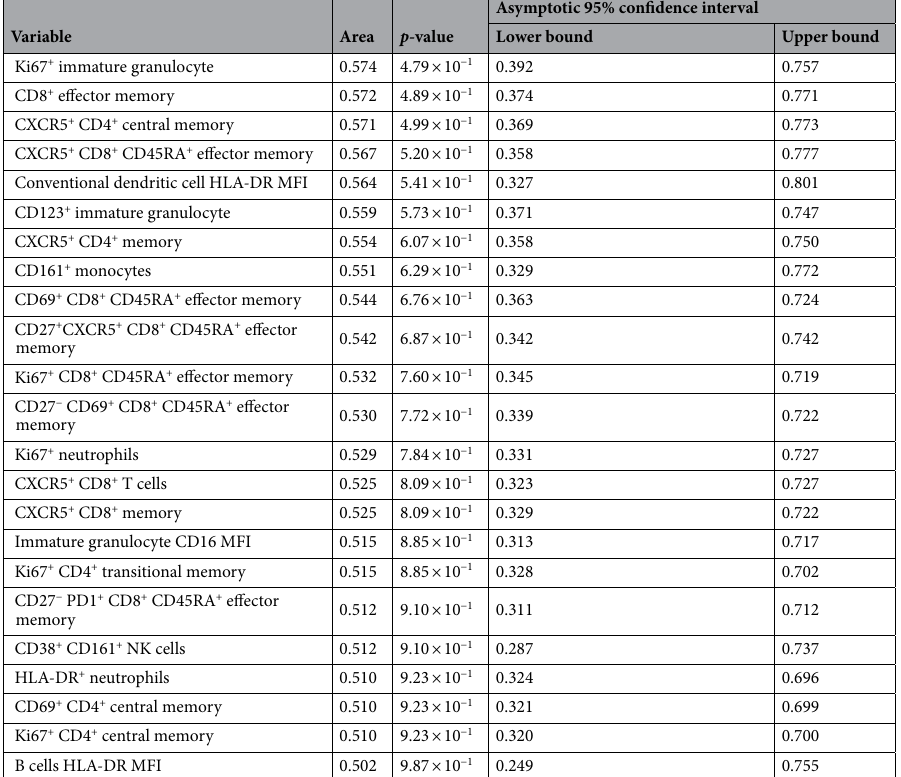
Table 4. Estimating the predictive ability of various analytes in identifying COVID-19 patients, regardless of disease severity status using the area under a receiver operating characteristic curve (AUC) method. BLR binary logistic regression probabilities. Shown p -values are corrected for multiple testing using Holm method. Cell populations are expressed as percentages of their respective parent populations except for where mean fluorescence intensity (MFI) is